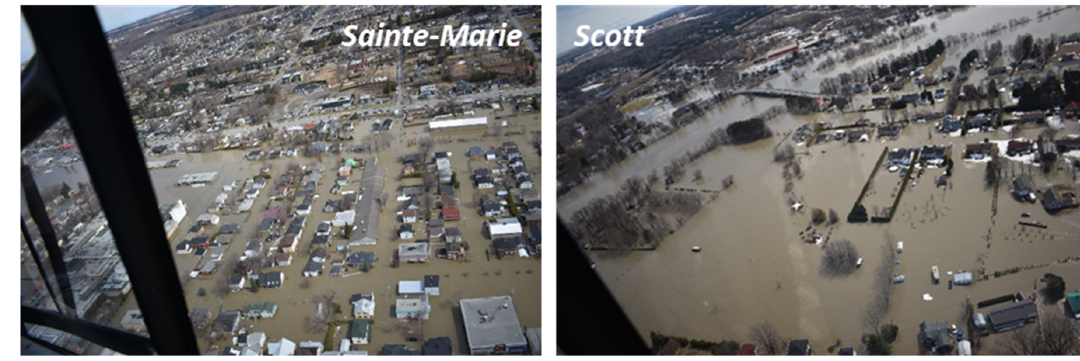
Figure 3. Extent of flooded areas: 21 April 2019.